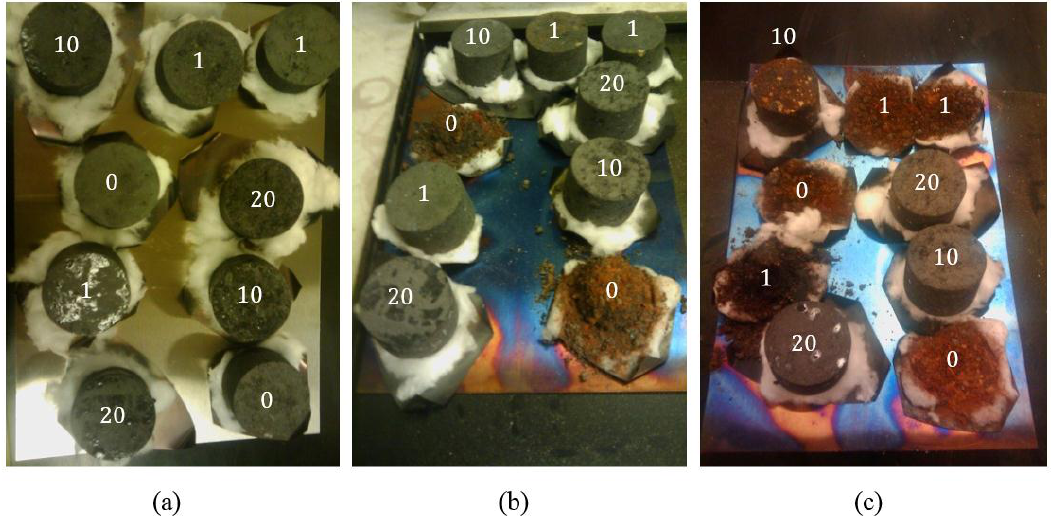
Figure 5. Visual observation of the samples; ( a ) before air reactivity test; ( b ) after 24 h of exposure; ( c ) after 6 days of exposure. The numbers on the samples indicate the impregnation time.